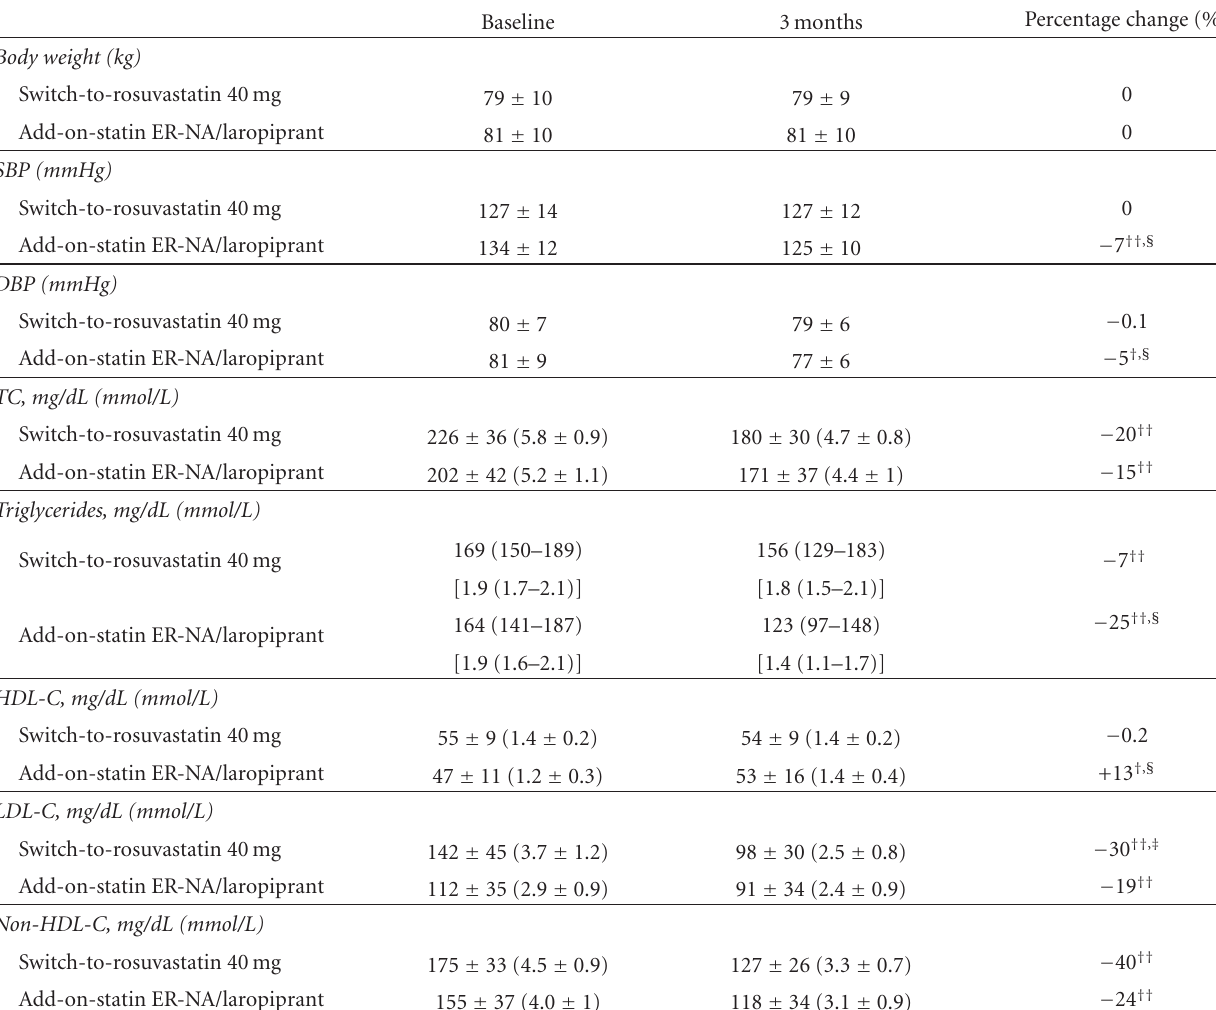
Table 2: Clinical and laboratory parameters at baseline and 3months after treatment ∗